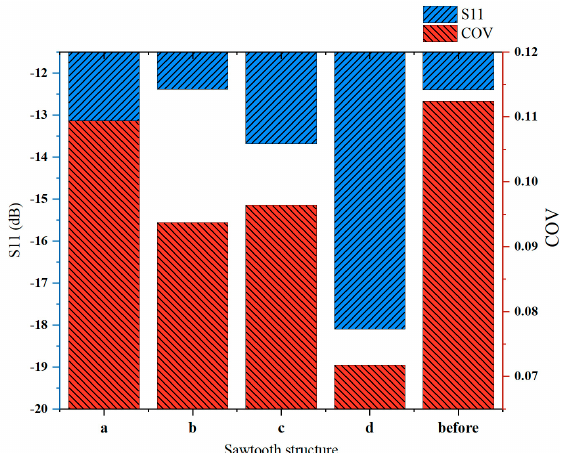
Figure 13. Reflection coefficient and heating uniformity of different structural solutions ( a – d ) rep- resent the case after adding each of the four sawtooth structures, and ‘before’ represents the case before adding).